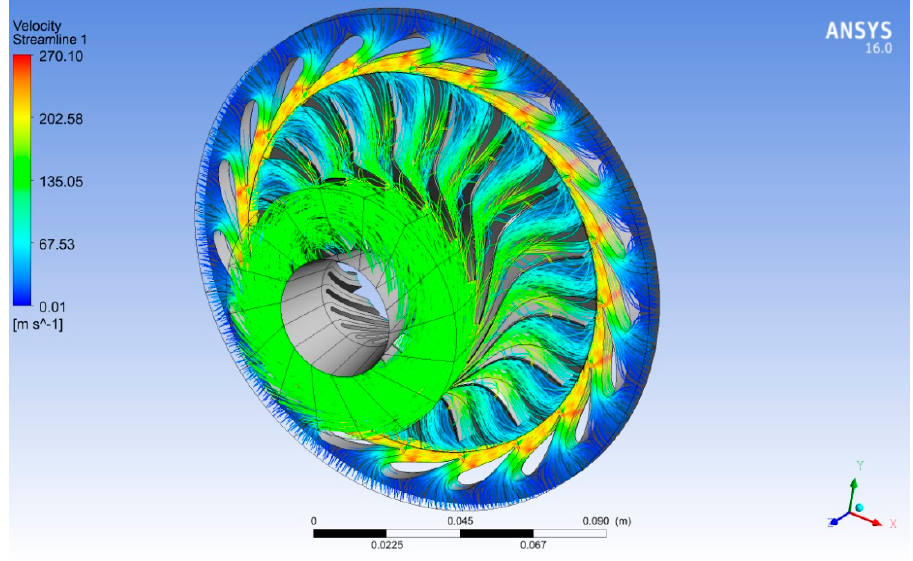
Figure 14. Three-dimensional velocity streamlines in case of R600a as a working fluid at 40,219 rpm.